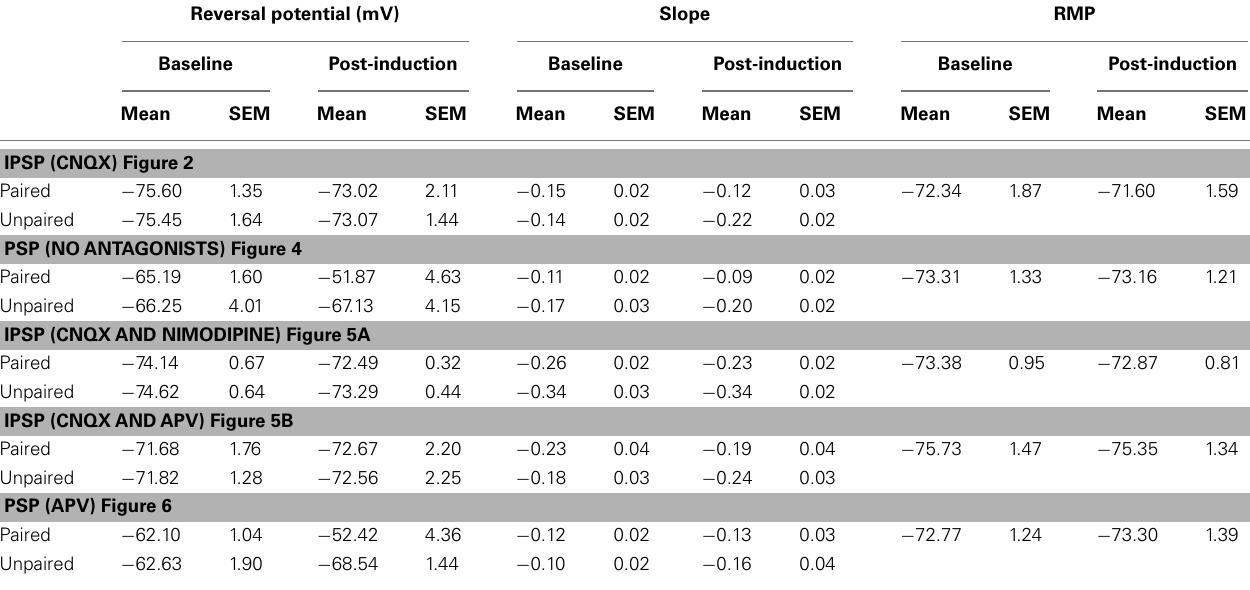
Table 1 | Electrophysiological properties of CA1 pyramidal neurons. Reversal potential, PSP slope, and RMP are reported for baseline and post-induction recordings made during plasticity recordings at both paired and unpaired inputs. Reversal potential (mV) Slope RMP Post-induction Baseline